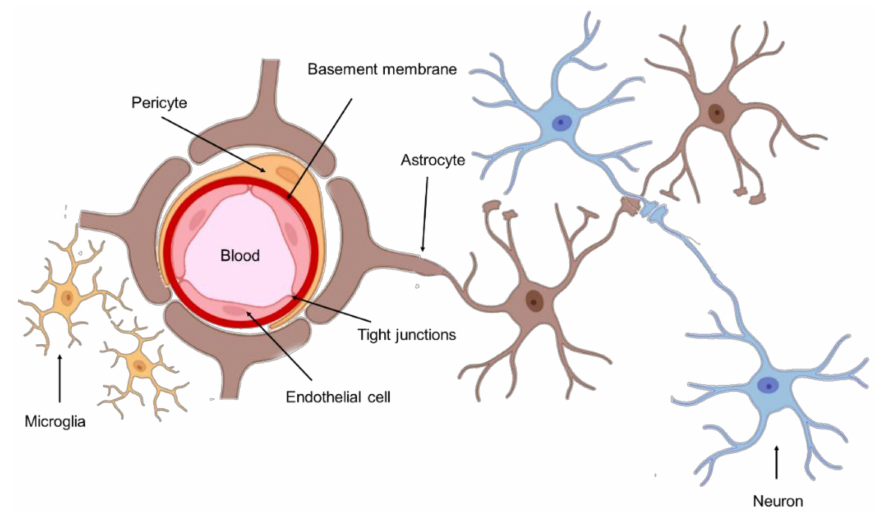
Figure 1. Schematic representation of the